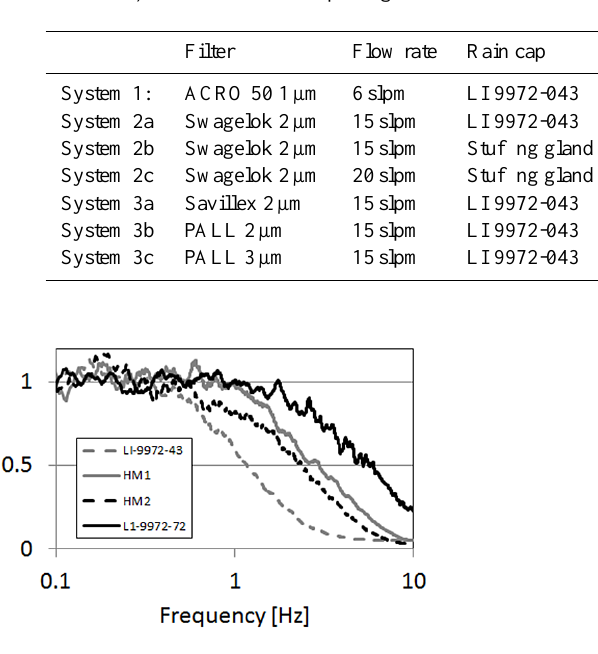
Figure 5. Transfer functions corresponding to different rain cap de- signs. Legend: dotted grey line: LI-9972-043; full grey line: HM1; dotted black line: HM2; full black line: LI-9972-072.